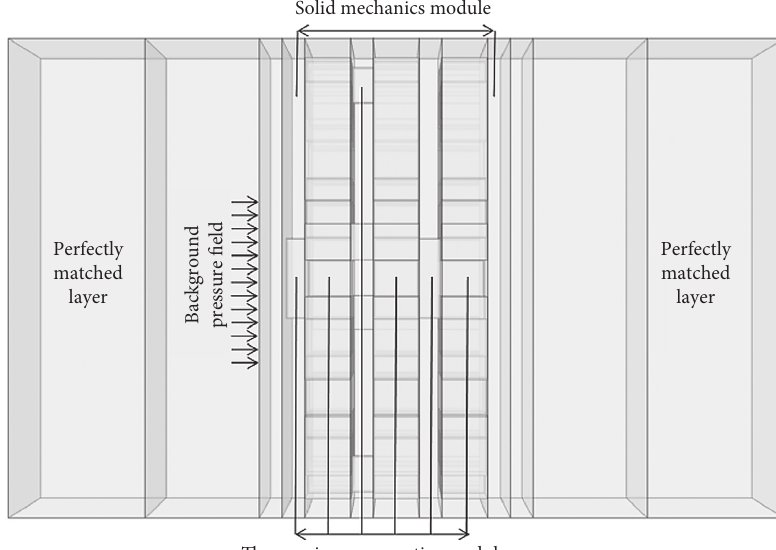
Figure 3: Multiphysics field coupling model.